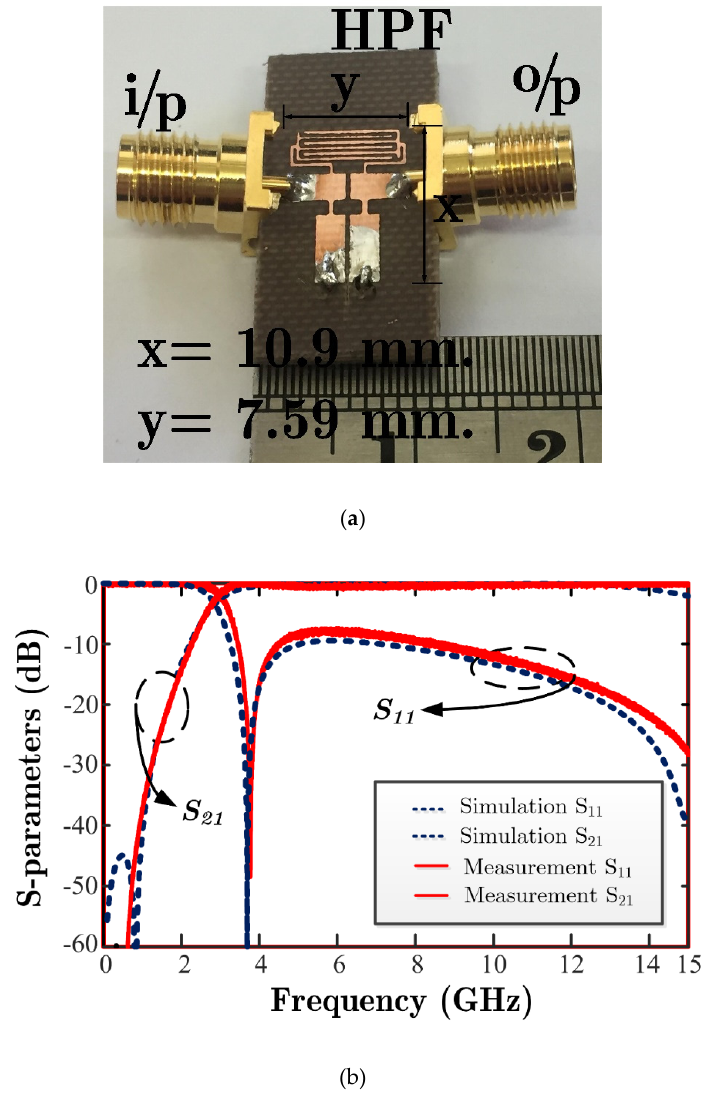
Figure 7. The prototype of the HPF: ( a ) A photograph of the HPF and ( b ) the simulated and measured results of the HPF with compensated inductors ( 𝐿 (cid:3043) = 0.68 nH). From Figure 3a, the LPF was constructed using the parameters in Table 2. The com- pensated inductors ( 𝐿 (cid:3043) = 0.2 nH ) were generated with the transmission line. The cut-off